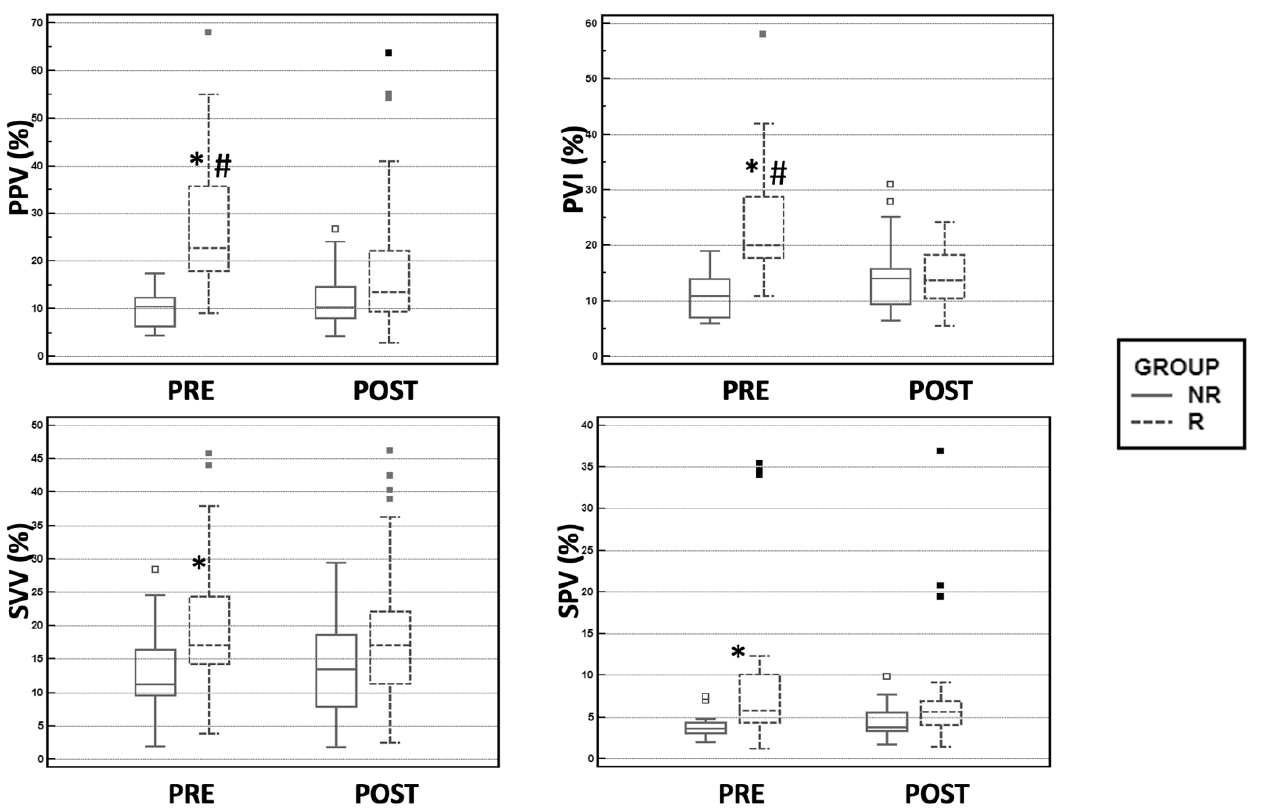
Figure 1. Box plot representation of the pulse pressure variation (PPV), plethysmographic variability index (PVI), stroke volume variation (SVV), and systolic pressure variation (SPV) before (PRE) and 2 min after (POST) fluid challenge administration of 5 mL/kg of Ringer’s lactate within 5 min. Based on the POST cardiac index (CI) variation, dogs were classified as responders (Rs; CI ≥ 15%) or nonresponders (NRs). The line within the box represents the median value. The upper and lower limits of the boxes represent the 25th and 75th percentiles of the data, respectively. The whiskers extend from the minimum to the maximum value. * p < 0.05 compared to NR; # p < 0.05 compared to POST within the same group. In Table 3, the cut ‐ off values, sensitivities, specificities, AUCs, grey ‐ zone limits, and number of grey ‐ zone cases are reported for each dynamic variable and the MAP. Table 3. Predictiveness of different dynamic indices and MAP in 80 dogs receiving fluid challenge under general anaes ‐ thesia. The best cut ‐ off values were determined based on the Youden index. Cut ‐ off values delimiting the grey zones were defined by values associated with 90% sensitivity and 90% specificity.